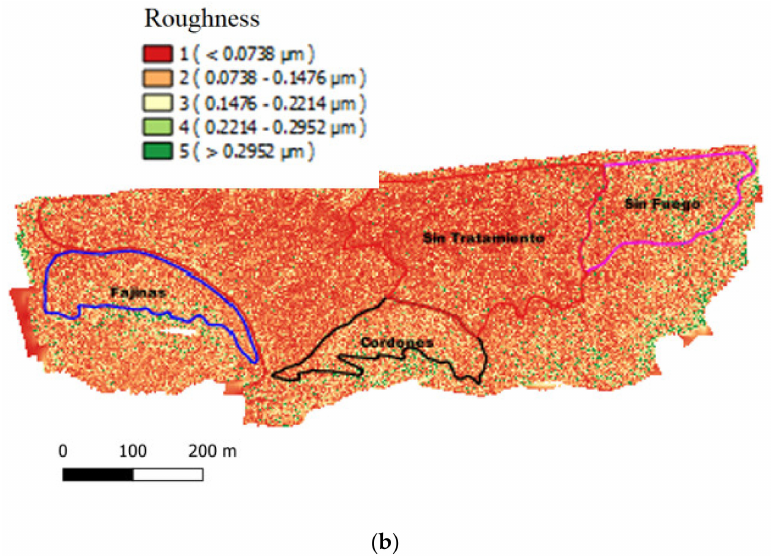
Figure 9. Spatial distribution of land slope ( a ) and terrain roughness ( b ) surveyed by UAV images of 2016 among four land conditions after the wildfire of 2012 in Sierra de Los Donceles forest (Castilla-La Mancha, Spain). Legend: Fajinas = log erosion barriers; cordones = contour-felled log debris; sin tratamiento = burned and no action; sin fuego =